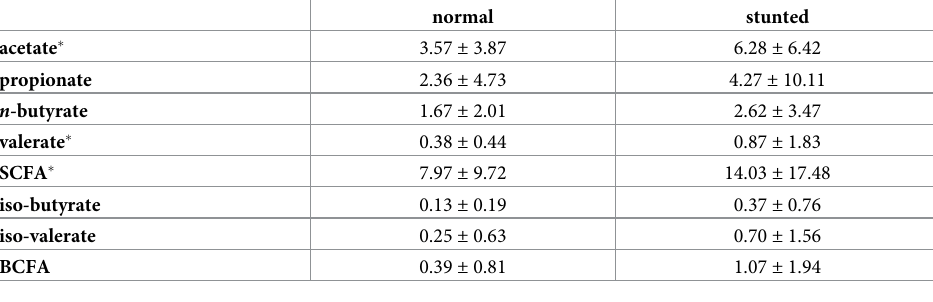
Table 2. Average ( ± SD) concentrations of individual and total SCFA and